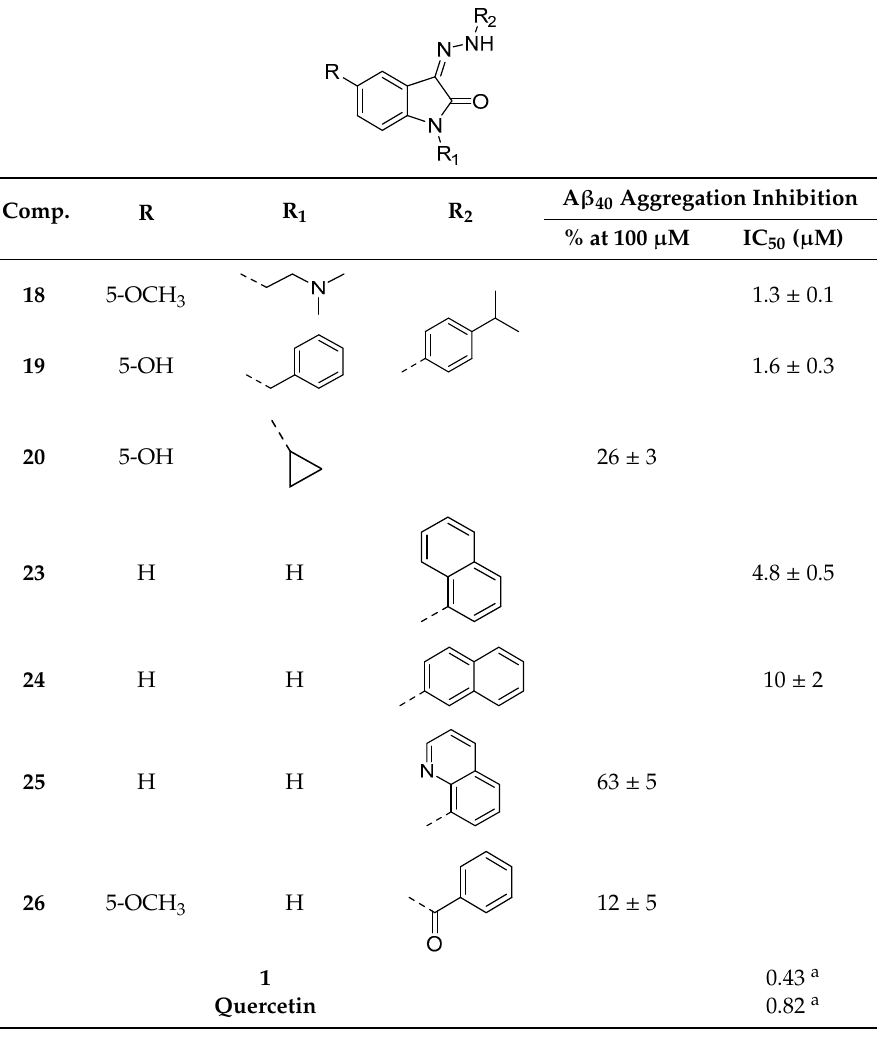
Table 1. Inhibition data of new isatin derivatives 18 – 20 and 23 – 26 .